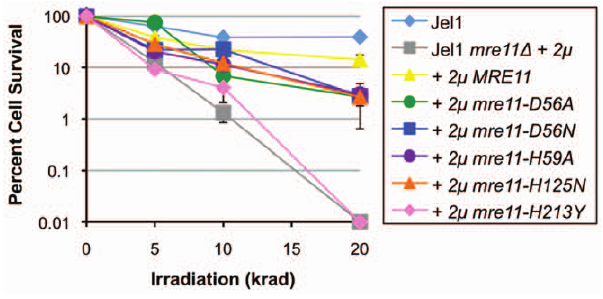
Figure 2. The mre11-H59A allele confers sensitivity to IR. Cell survival was measured following indicated exposure to radioactive 137 Cs, and normalized to unirradiated samples. Error bars indicate standard error of the mean. Strain notations as in Fig. 1.